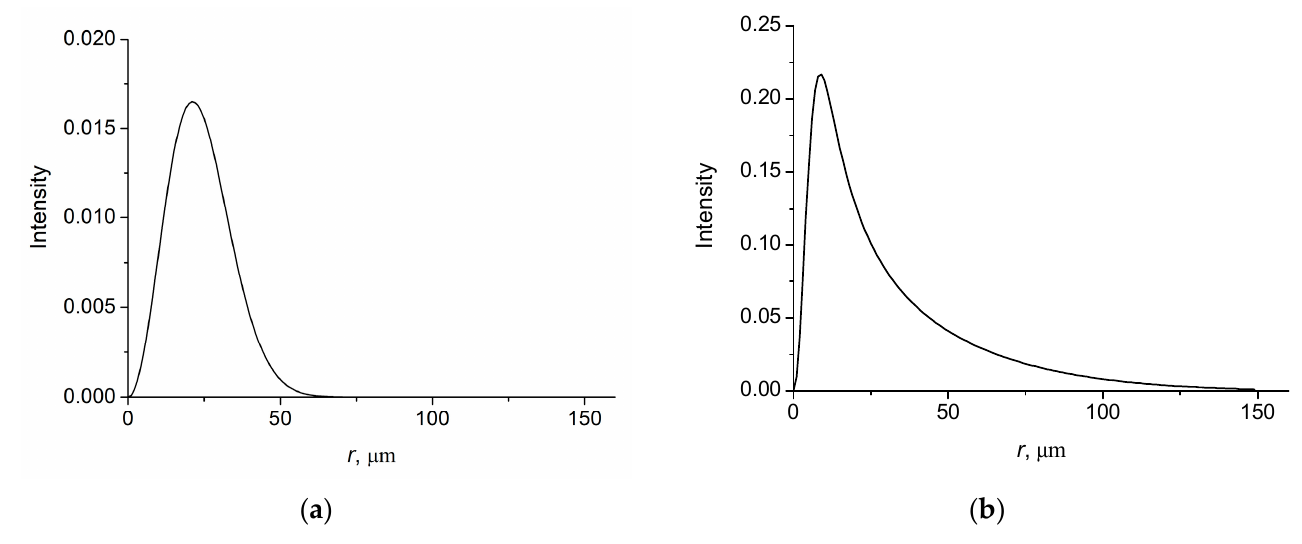
Figure 2. Intensity distributions of BG vortex beam with l = 1. w = 30 µm ; ( a ) ξ = 0.02; r coh = 100 µm ; ( b ) ξ = 0.80; r coh = 10 µm .